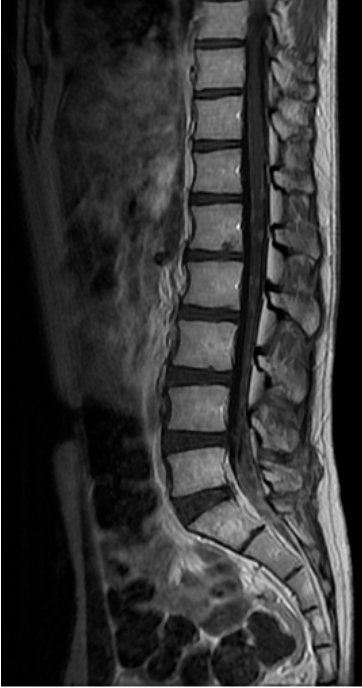
Figure 2. Cervical leptomeningeal carcinomatosis of an ALK-rearranged NSCLC after failure of the first- and second-generation ALK inhibitors (crizotinib and alectinib, respectively).